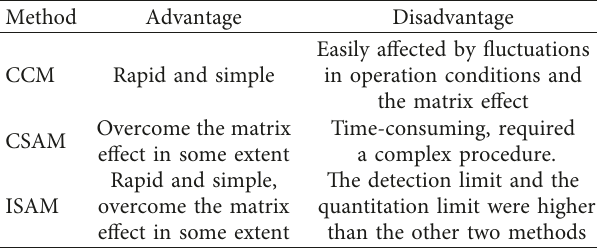
Table 1: Difference between each analysis strategy.